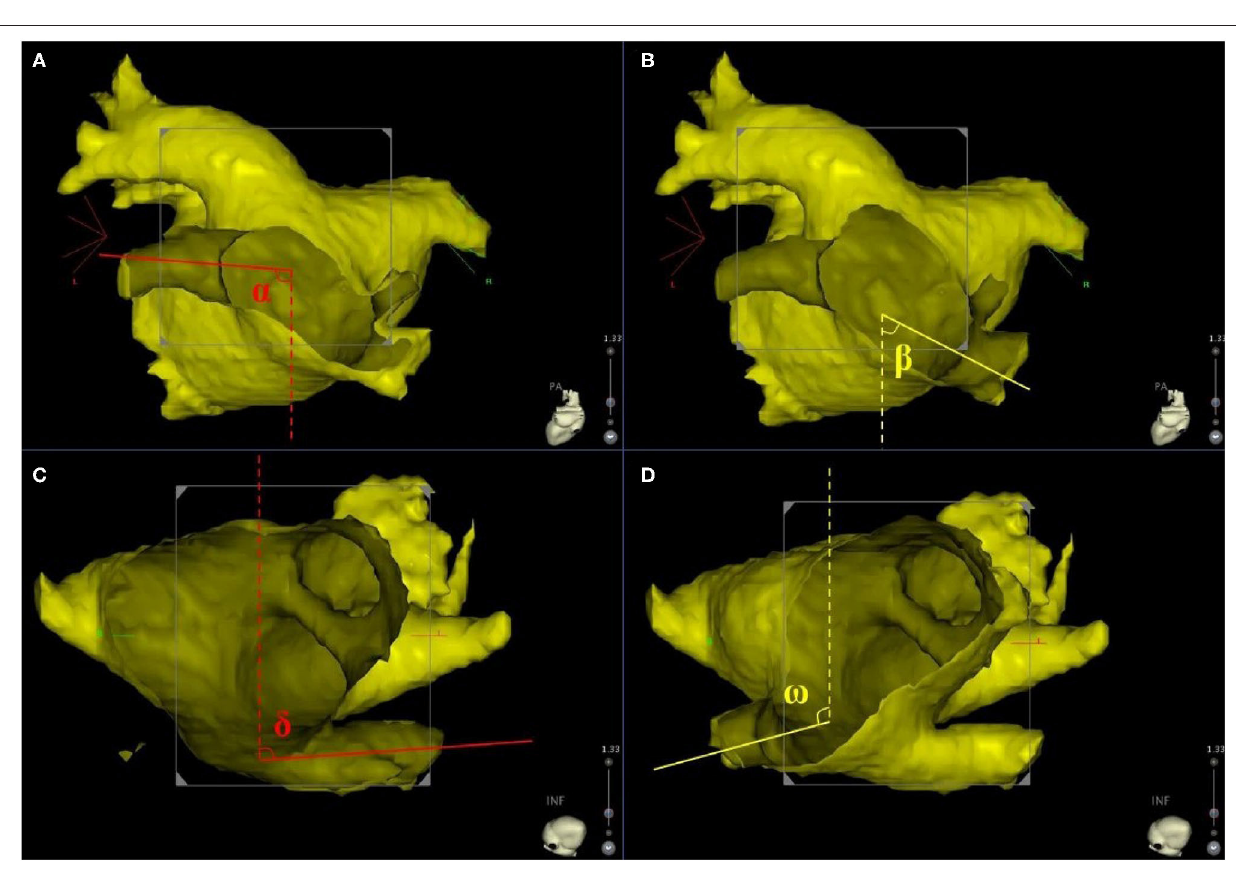
FIGURE 2 | The principle axis of LIPV (red line) and RIPV (yellow line) were identified in frontal and transverse planes. (A,B) Display the frontal orientation measurements of LIPV and RIPV, resectively. Angles α and β represent for the angles between LIPV, RIPV, and the sagittal plane reference (dotted line) in the frontal plane. (C,D) display the transverse orientation measurements of LIPV and RIPV, resectively. Angles δ and ω represent for the angles between LIPV, RIPV, and the sagittal plane reference (dotted line) in the transverse plane. LIPV, left inferior pulmonary vein; RIPV, right inferior pulmonary